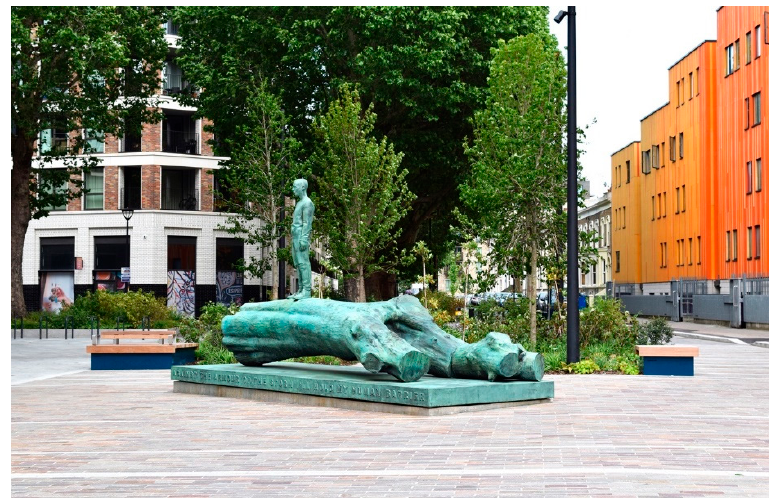
Figure 1. Kenny Hunter, Southwark Memorial, 2018. Image courtesy of Kenny Hunter.